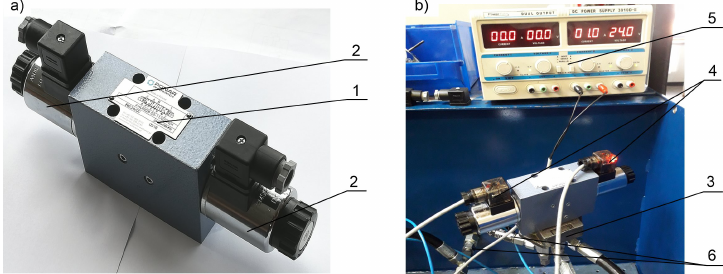
Figure 17. Laboratory equipment; ( a ) valve prototype, ( b ) test bench; 1—valve body, 2—electromagnet, 3—mounting plate, 4—power connectors, 5—power supply, 6—pressure